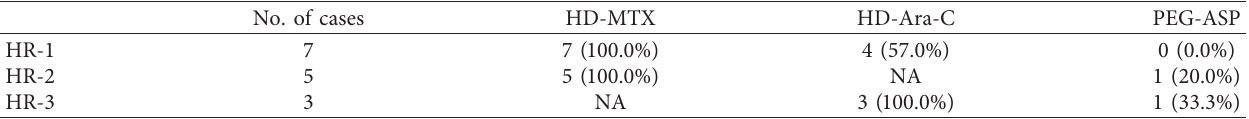
Table 7: Cases assessed as high causality of “probable” or “highly probable” in HR